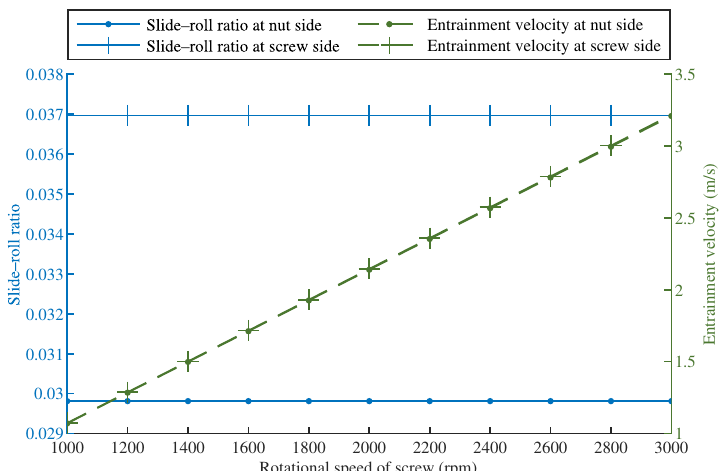
Figure 5. Slide–roll ratio and entrainment velocity under various rotational